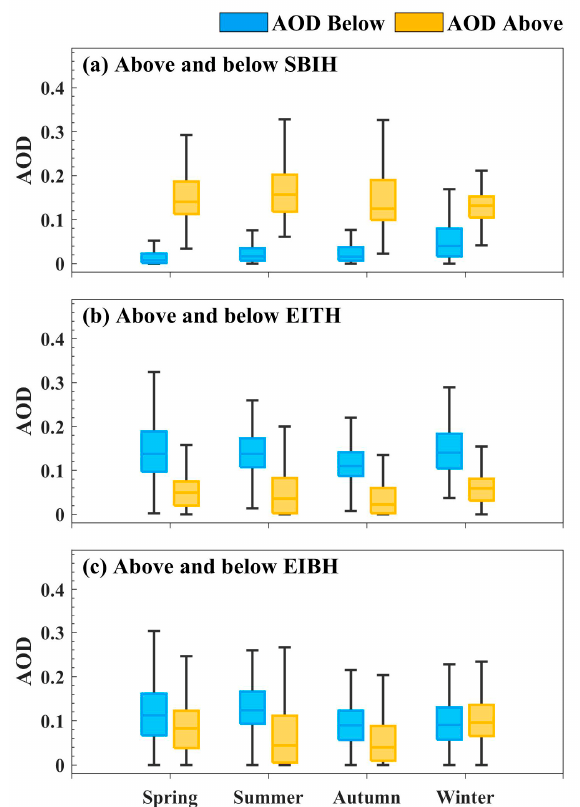
Figure 7. The Aerosol optical depth above and below ( a ) surface-based inversion height, ( b ) elevated temperature inversion top height, and ( c ) elevated temperature inversion bottom height under different seasons. The blue and orange boxes represent the aerosol optical depth below and above temperature inversion, respectively.